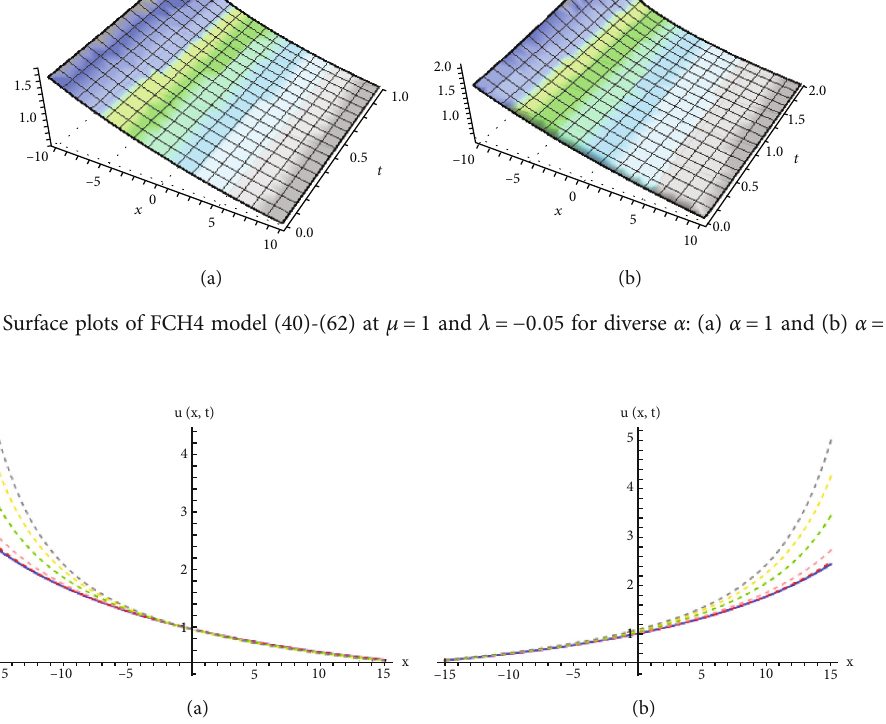
x , t Þ of FCH4 model (40) and (62) with t = 1 and μ = 1 : blue for q -HAM [24], red α = 1 , pink Figure 6: Fractional level curves of u 3 ð α = 0 : 75 , green α = 0 : 5 , yellow α = 0 : 25 , gray α = 0 : 1 ; (a) λ = − 0 : 05 and (b) λ = 0 : 05 . Table 4: Comparison of absolute errors of FCH4 model (40) and (62) with = 1, μ = 1 , and λ = 0 : 01